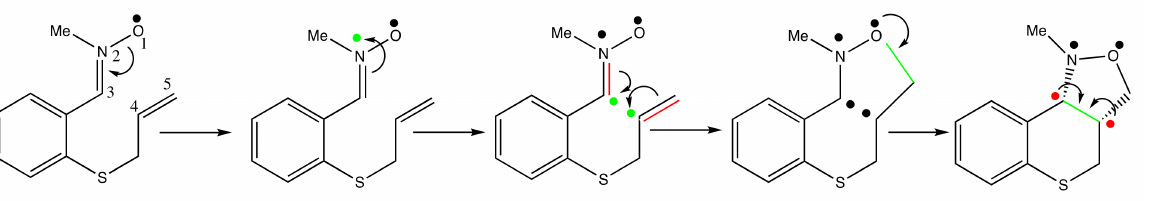
Scheme 6. Curly arrow representations of the main electron density flows of the reaction from 5 to 6